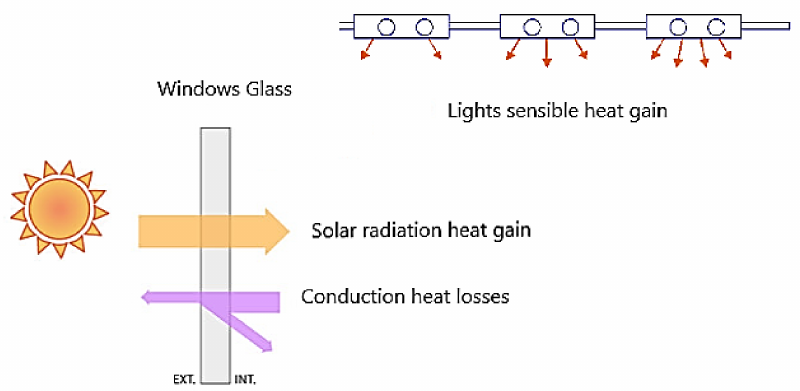
Figure 7. Lights, solar heat gain, and heat losses caused by the window glass.